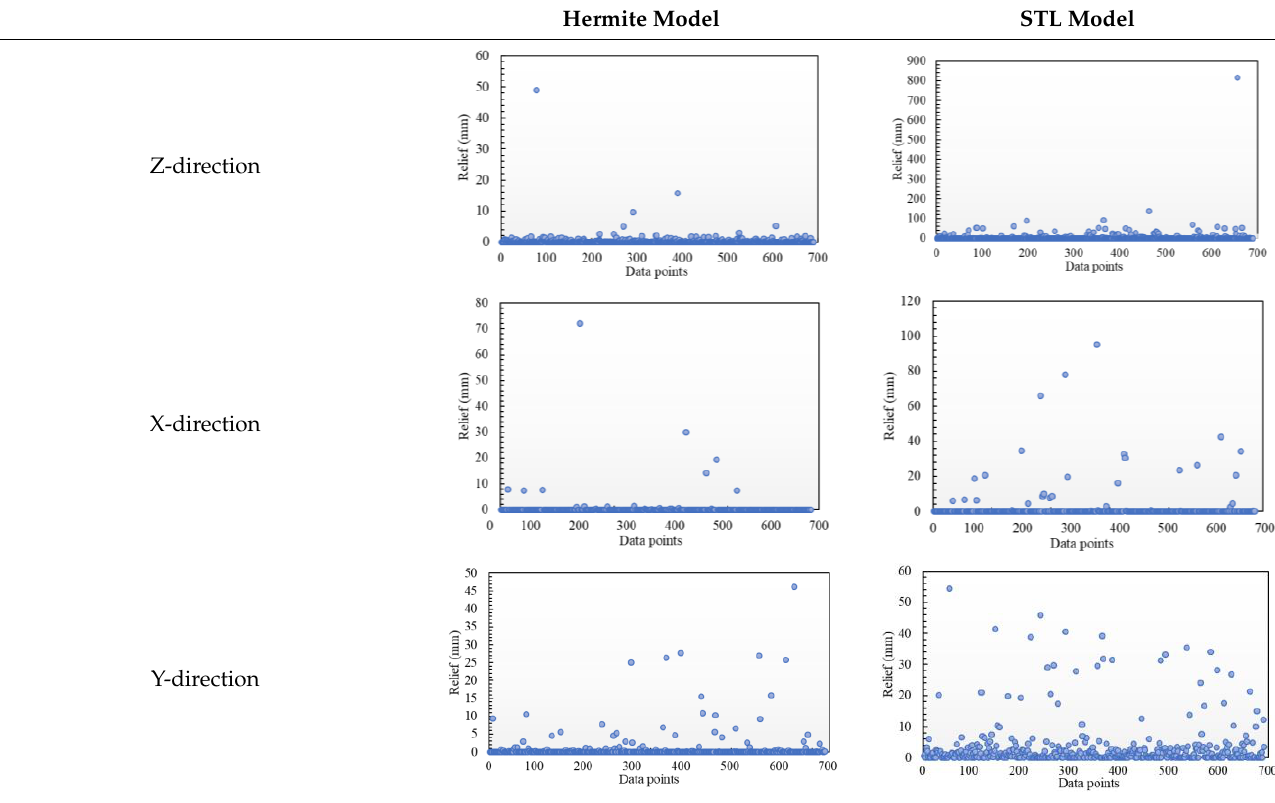
Table 3. Mean deviation in the three directions in group 5.